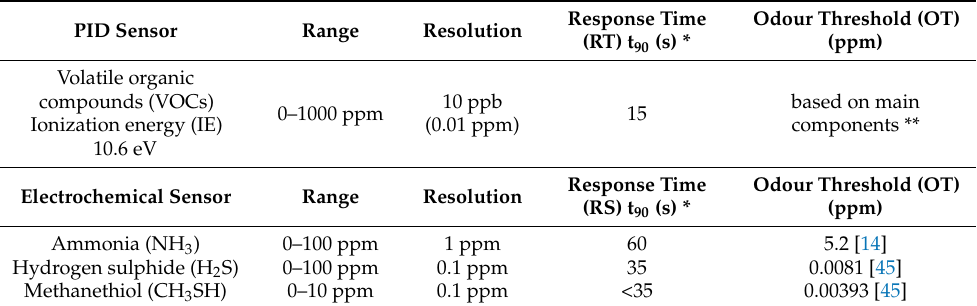
Table 1. Sensor specifications of a gas detector MultiRae Pro and threshold level of odour identifica- tion for selected chemical